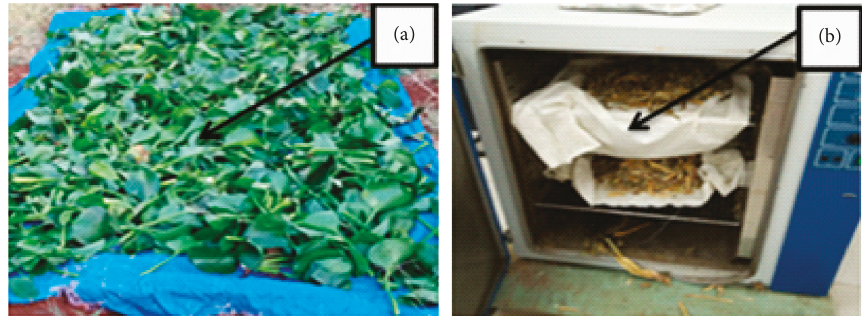
Figure 1: (a) Freshwater hyacinth leaves in sun drying and (b) water hyacinth parts in oven drying.